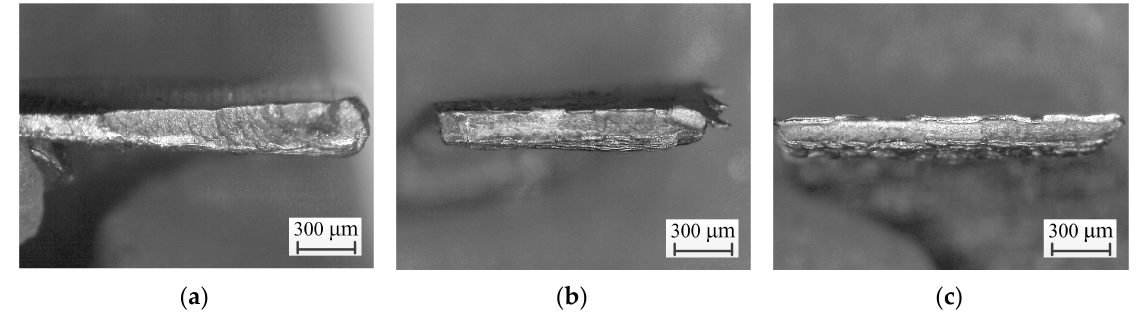
Figure 4. Cross-sections along the flowing out of the chip: ( a ) central tooth, ( b ) intermediate tooth, ( c ) external tooth.